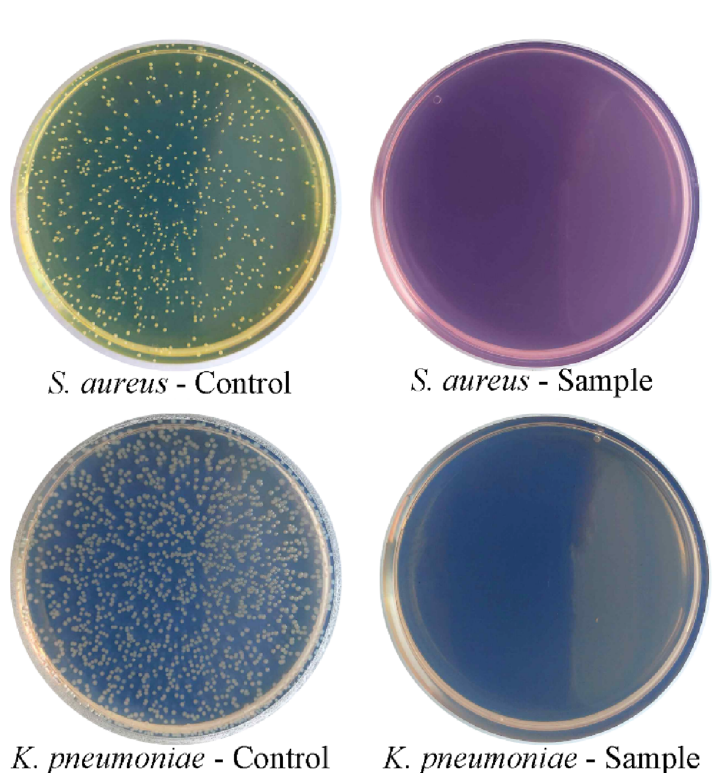
Fig. 8 Antibacterial test results of cotton fabrics dyed with Aronia berries extract after chitosan